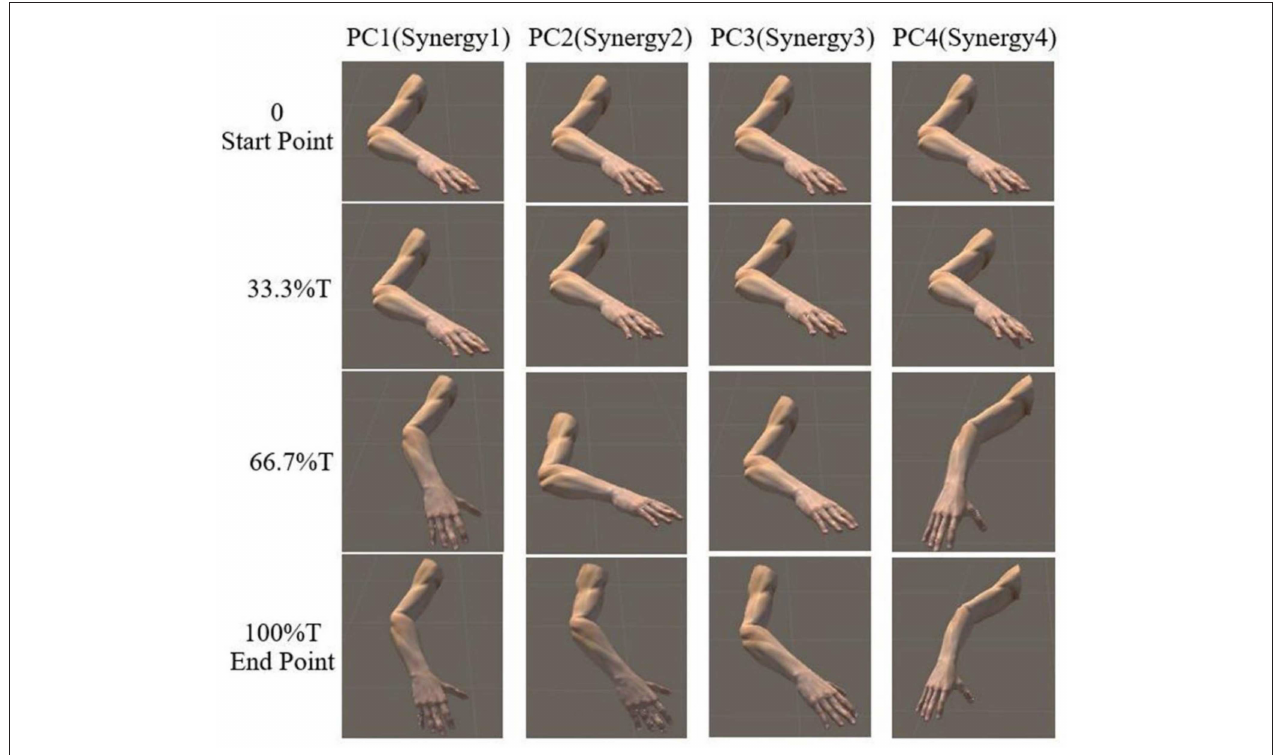
FIGURE 8 | Simulated posture visualization for first four PCs (synergies) at four specific time points of subject